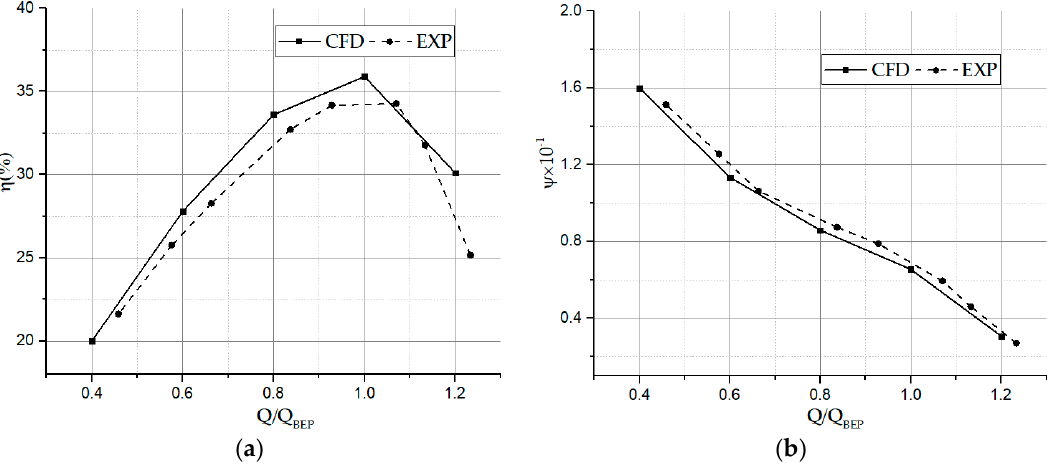
Figure 14. Hydraulic performance comparison between the experimental data and CFD under pump case 2 ( a ) efficiency ( b ) head coefficient.